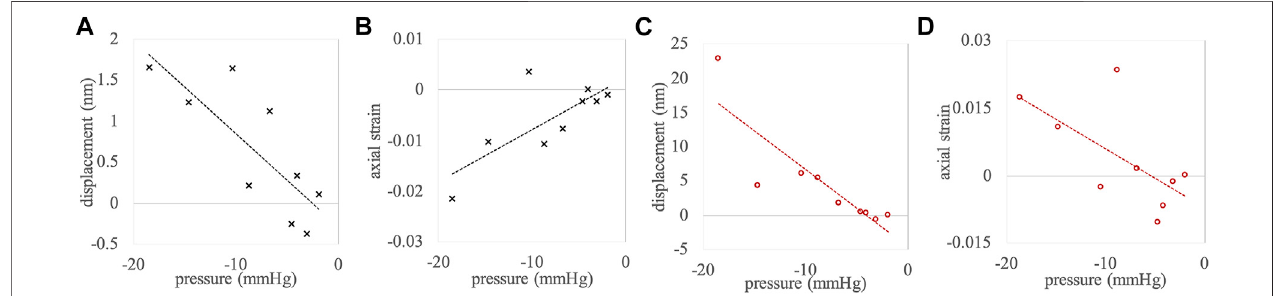
FIGURE 4 | Correlations between pressure change and (A) corneal displacement, (B) corneal strain, (C) anterior crystalline lens displacement, and (D) anterior crystalline lens strain. Measurement points represent the complete data set ( n (cid:2) 9).